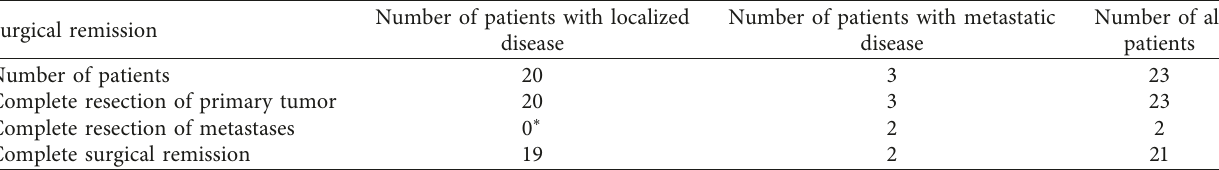
Table 2: Complete surgical remission in localized and metastatic disease.